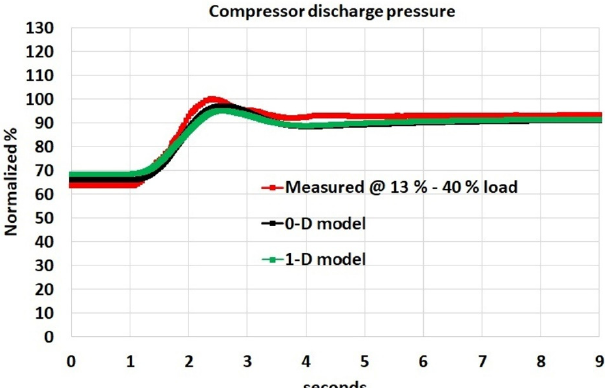
Figure 9. Compressor discharge pressure with increasing load from 13% to 40% of the maximum load and with no bleed. Machines 2020 , 8 , x FOR PEER REVIEW 9 of 19